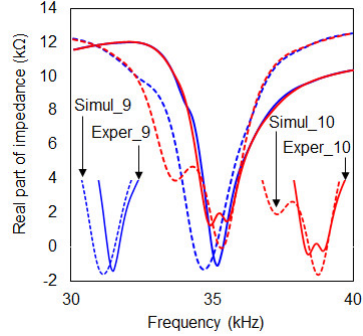
Figure 12. FEA simulation results versus experimental results (cut steps 9 and 10).